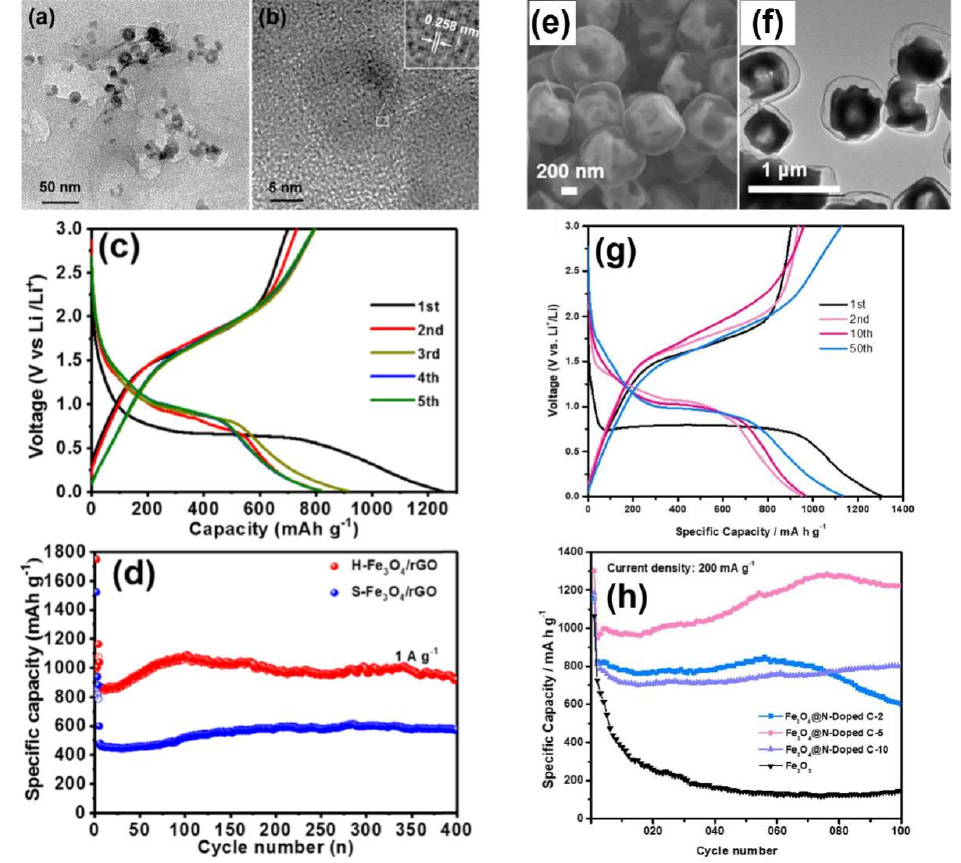
Figure 5. ( a ) Low-resolution transmission electron microscopy (TEM) image of hollow Fe 3 O 4 anchored on reduced graphene oxide (rGO) [15] with a scale bar of 50 nm. ( b )